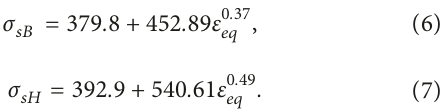
Figure 12: J–C constitutive model. (a) Base material. (b) Heat-affected